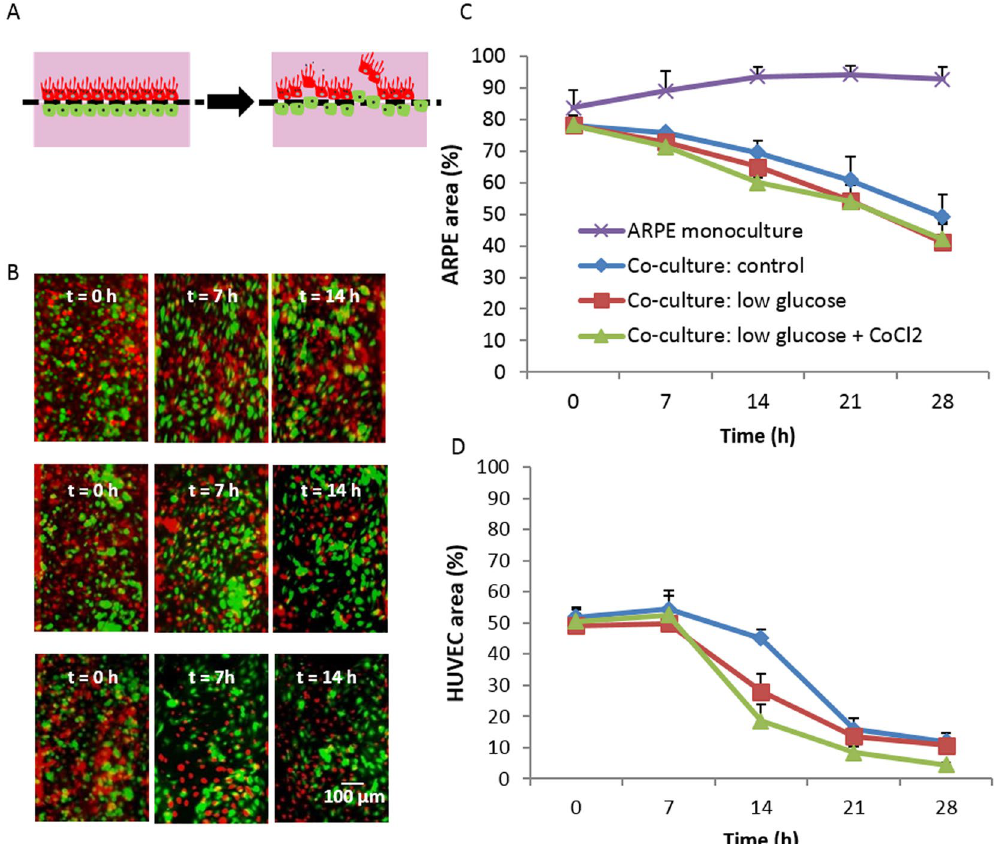
Figure 4. Analysis of the co-culture model. ( A ) Anticipated behaviour of cells within the microfluidic device where ARPE-19 detached due to the invasion of HUVEC; ( B ) Overlaid images of ARPE-19 and HUVEC at different time points; top row: control, middle row: low glucose, bottom row: low glucose with the addition of CoCl 2 ; ARPE-19 is depicted in red and HUVEC in green in all cases. ( C , D ) Quantification of the ARPE-19 and HUVEC growth area under different medium conditions and monoculture of ARPE in DME High glucose medium. Data were analyzed using 2-way ANOVA tests (showing a significant interaction effect, p < 0.0001 for ( C ) and ( D )). Significant difference between the ARPE monolayer (purple line) and the co-culture groups (blue, red and green lines) is observed from t = 7 and onwards (p ≤ 0.0001). Pairwise comparisons between co-culture control and low glucose & hypoxia at t = 14 h (p = 0.023), and between all co-culture groups at t = 21 and t = 28 h (p < 0.0001) are significant in ( C ). In ( D ), pairwise comparisons for low glucose and low glucose & hypoxia groups (red and green lines) at t = 14 compared to t = 0 are significant (p ≤ 0.001). N =